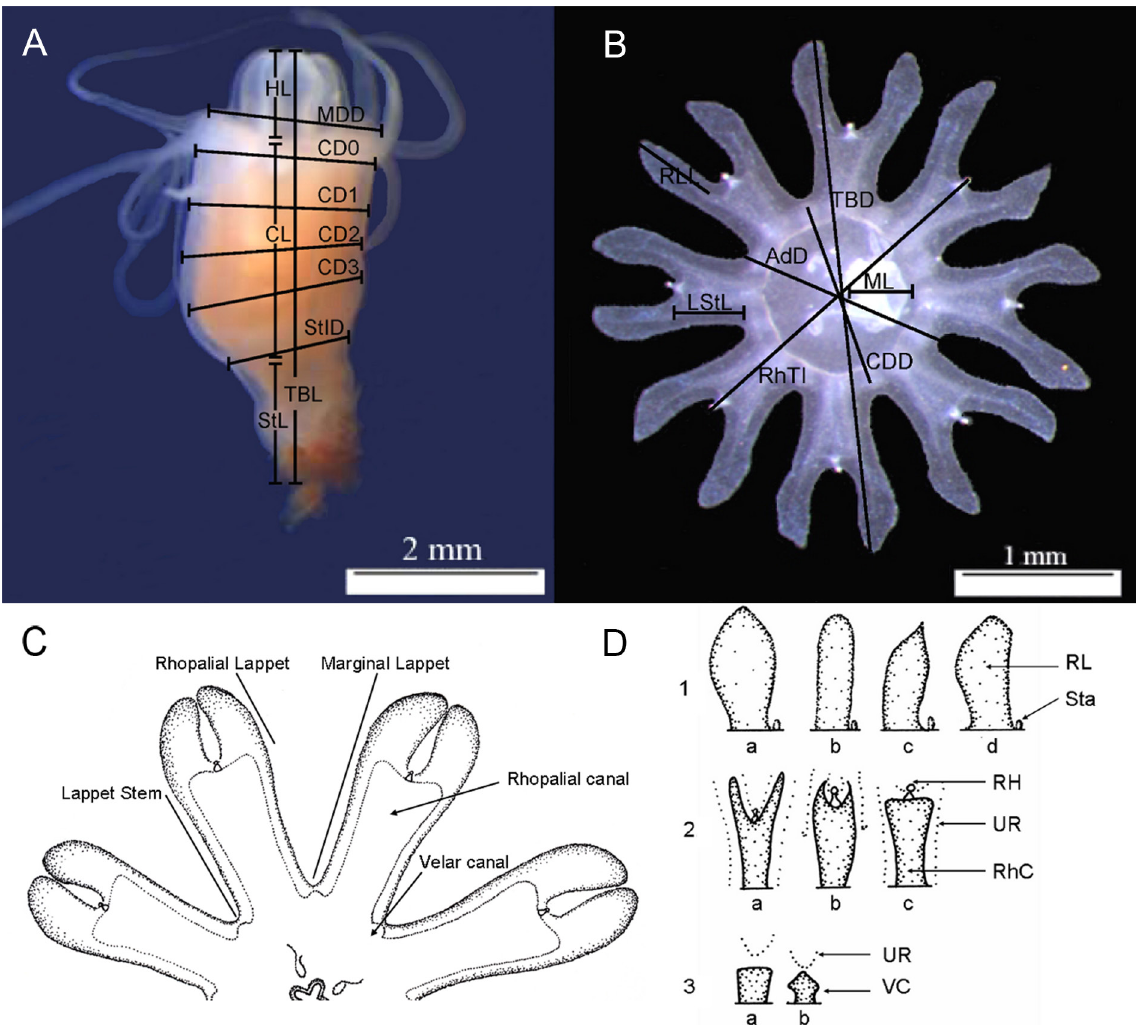
Fig. 1. Measurements of: A . Scyphistomae. B . Ephyrae. C . Lappets of an ephyra: the marginal lappet can be divided into rhopalial lappet and lappet stem; also visible are the rhopalial and velar canals. D . Rhopalial lappet and gastric canal forms of ephyrae in this study: 1 . Rhopalial lappet forms (i.e. left lappet): (a) pointed spoon-like, (b) round spatula-like, (c) lancet-like and (d) bread knife-like; 2 . Rhopalial canal forms: (a) forked, sharp points, (b) club-shaped, forked, sharp points and (c) spade-like; 3 . Velar canal forms: (a) spade-like and (b) rhombic. Abbreviations: RH = rhopalium; RhC = rhopalial canal; RL = rhopalial lappet; Sta = statolith; UR = umbrella rim; VC = velar canal. Other abbreviations: see Table 2. Modified after Straehler-Pohl & Jarms